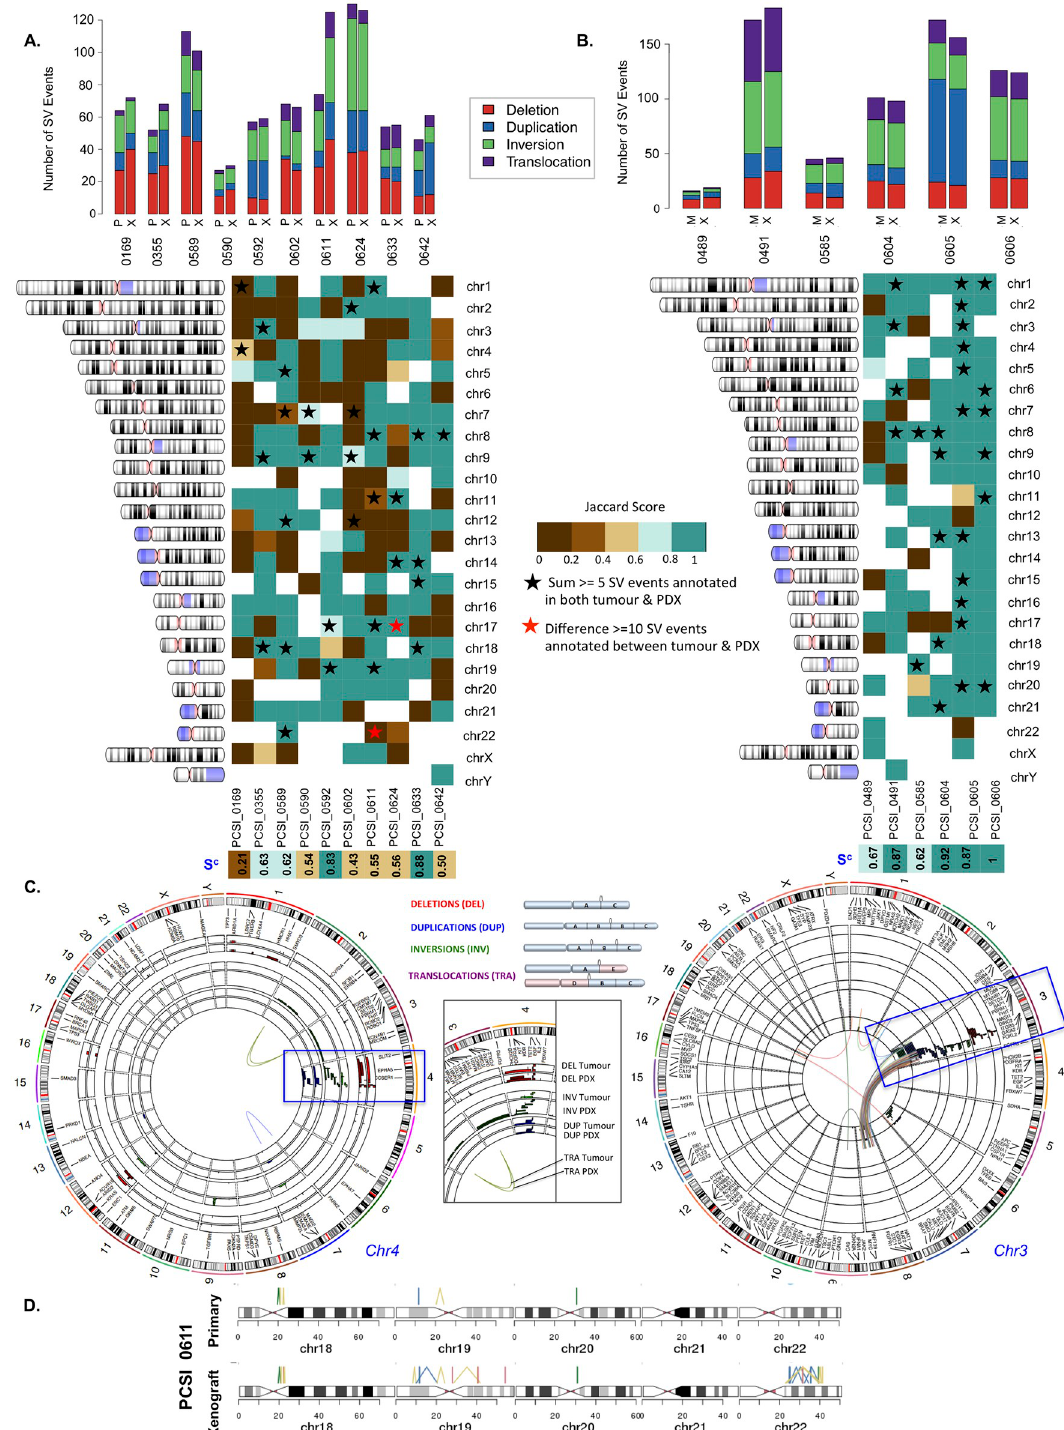
Fig 5. Comparative analysis of structural variation (SV) across tumour-PDX pairs of the primary and metastasis cohorts. (A) Distribution of SV events (deletion, duplication, inversion, translocation) in each sample across 10 primary-PDX pairs (left) and 6 metastasis-PDX pairs (right). (B) Chromosome-specific Jaccard indices across 10 primary-PDX pairs (left) and 6 metastasis-PDX pairs (right). Samples are labeled by their PCSI identifier. Chromosomes with an observed large number of rearrangements ( � 5 events) in both the tumour and matched PDX are indicated (black stars). Chromosomes with a large difference of SV events between